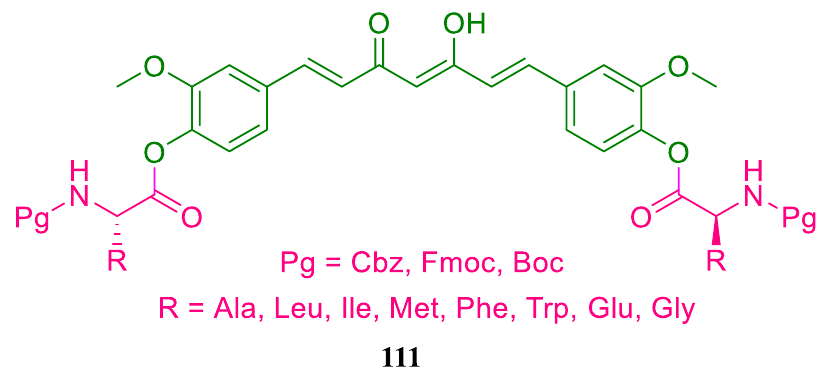
Figure 90. Curcumin bis -conjugates ( 111 ) of different N-protected amino acids.